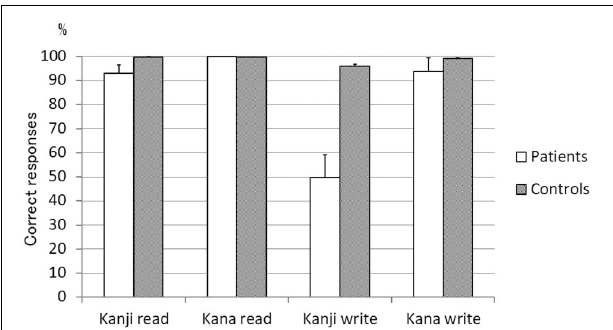
FIGURE 1 | Mean rate of correct responses in the 100 single-character kanji and kana transcription test. Kanji writing was the most impaired. Kana writing and kanji reading were equally slightly impaired ( n = 7). Error bar denotes standard error.